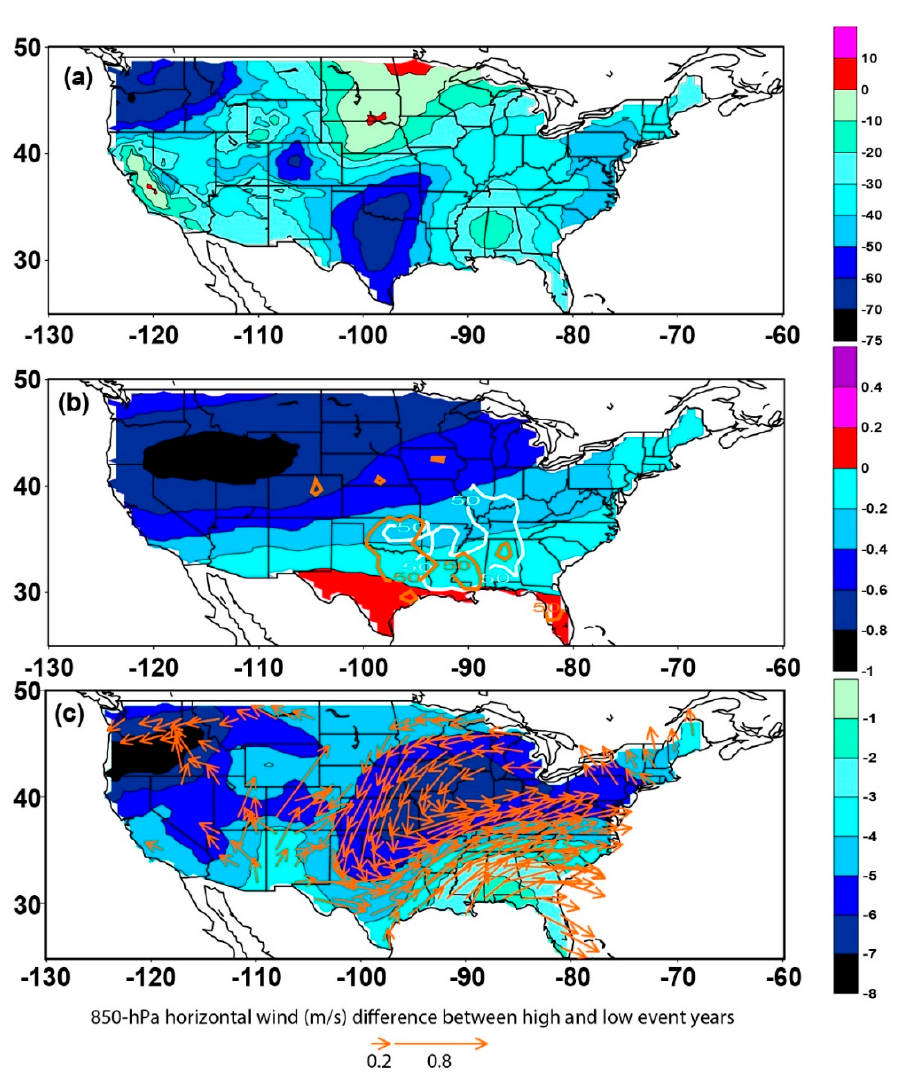
Figure 11. Composite differences between high and low event years of ( a ) mean sea level pressure (Pa) (shaded), ( b ) 500-hPa air temperature (°C) (shaded), and ( c ) 850-hPa geopotential height (m) (shaded) and horizontal velocity (m s − 1 ). Tornado Alley is defined as the core area of (E)F1-(E)F5 tornado counts of 50 or more per 1° × 1° grid box over a 30-year period with orange color contours (in the cold period) and white color contours (in the warm period) in ( b ).